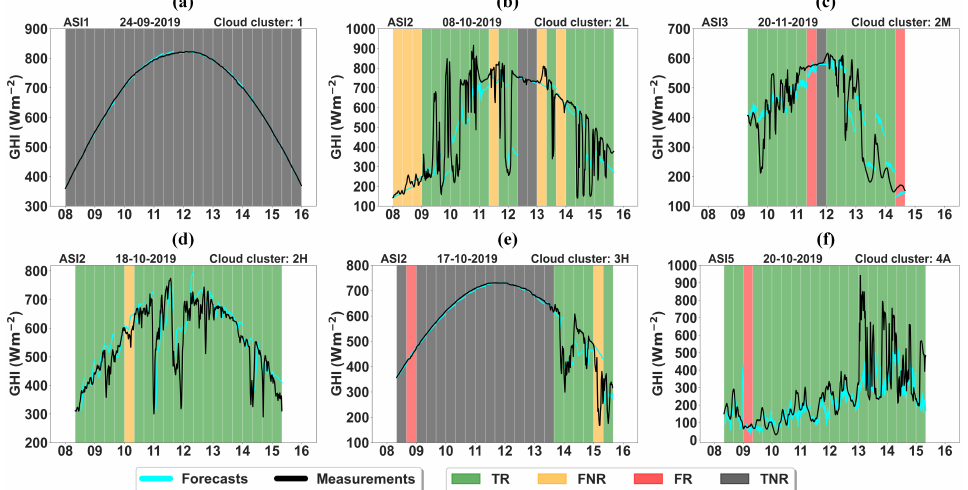
Figure 10. Intra-day variability of the four possible ramp event-detection cases included in Table 2 for the 20 min window analysis, TW, at selected days and ASIs for cloud cluster: ( a ) 1, ( b ) 2L, ( c ) 2M, ( d ) 2H, ( e ) 3H and ( f ) 4A. For the sake of clarity and to ensure continuity, the presented 20 min windows include the ramp event nowcasts having as a starting forecast time point the exact time (e.g., 08:00, 08:20 UTC, etc.) and containing up to 20 min (e.g., 08:01–08:20, 08:21–08:40 UTC, etc.) in minute-by-minute increments. The background colors in each graph correspond to the four possible cases in Table 2. The solid black and cyan lines correspond to measured GHI and model-based GHI nowcasts within each 20 min